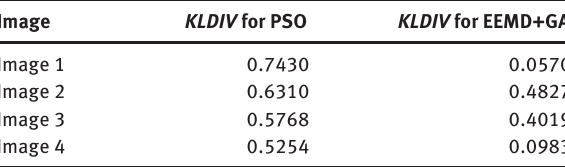
Table 2. Results for KLDIV .